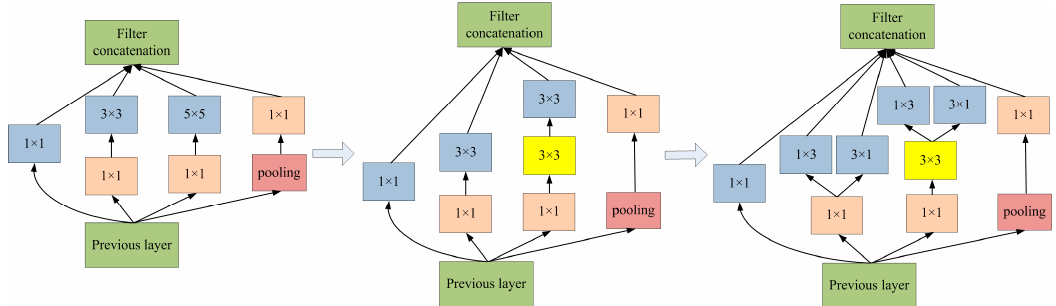
Figure 2. Changes of inception module in the architecture of Inception V3; n × n denotes the n × n convolutional operation.